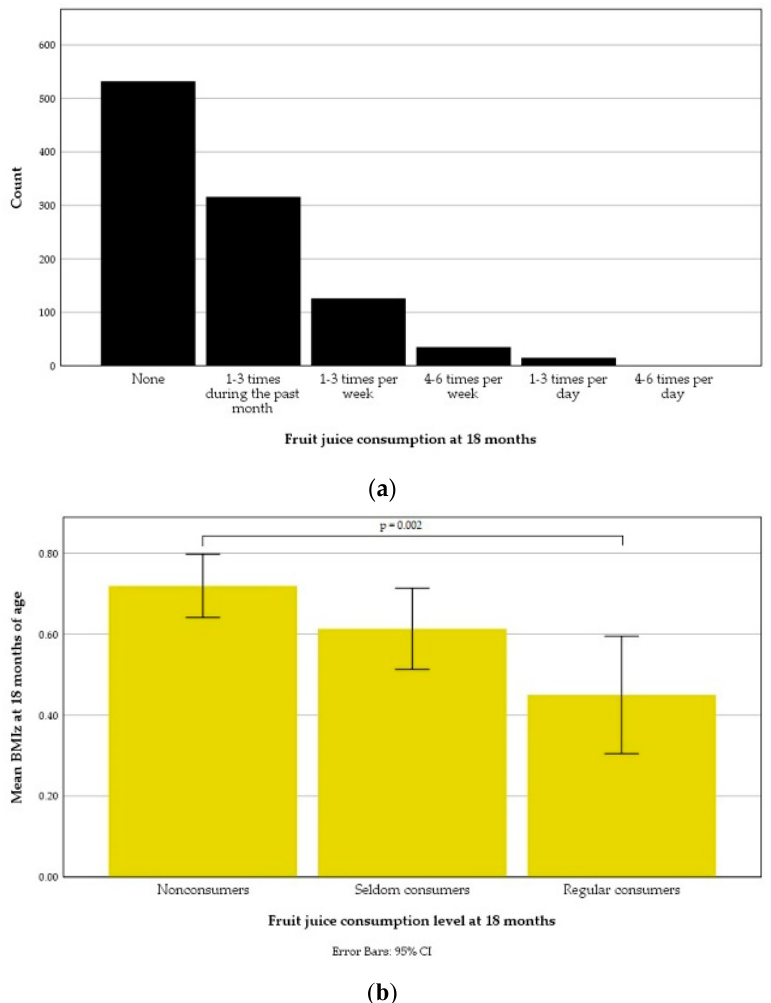
Figure 3. Fruit juice consumption during the past month at 18 months of age: ( a ) Distribution according to one-month-recall food frequency questionnaire responses; ( b ) An error bar graph illustrating mean body-mass index z -score (BMIz) at 18 months of age according to consumption level.